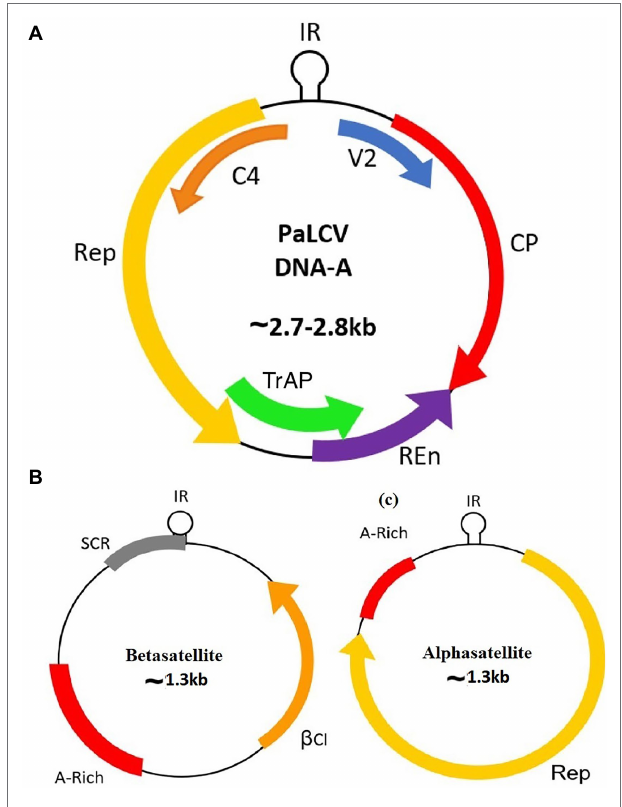
FIGURE 1 | Genome organisation of the Papaya Leaf Curl Virus with associated satellites. (A) DNA-A; (B) Betasatellite; and (C)